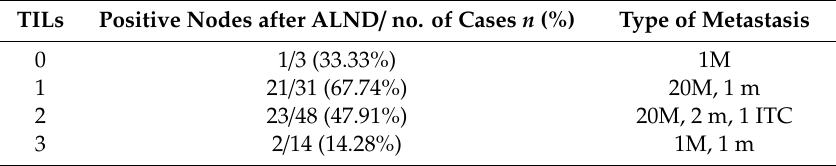
Table 3. Lymph nodes status according to TILs values in the SST group.